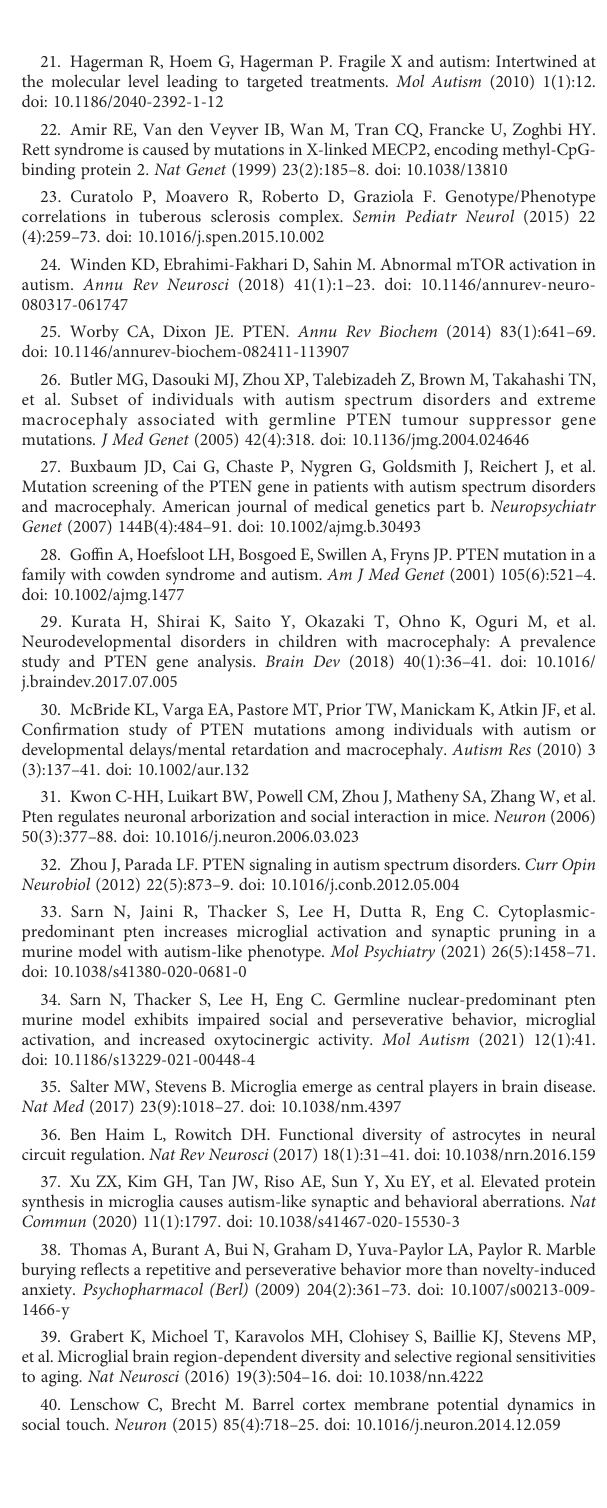
SUPPLEMENTARY TABLE 2 List of genes belonging to KEGG pathways including oxidative phosphorylation, AD and PD.